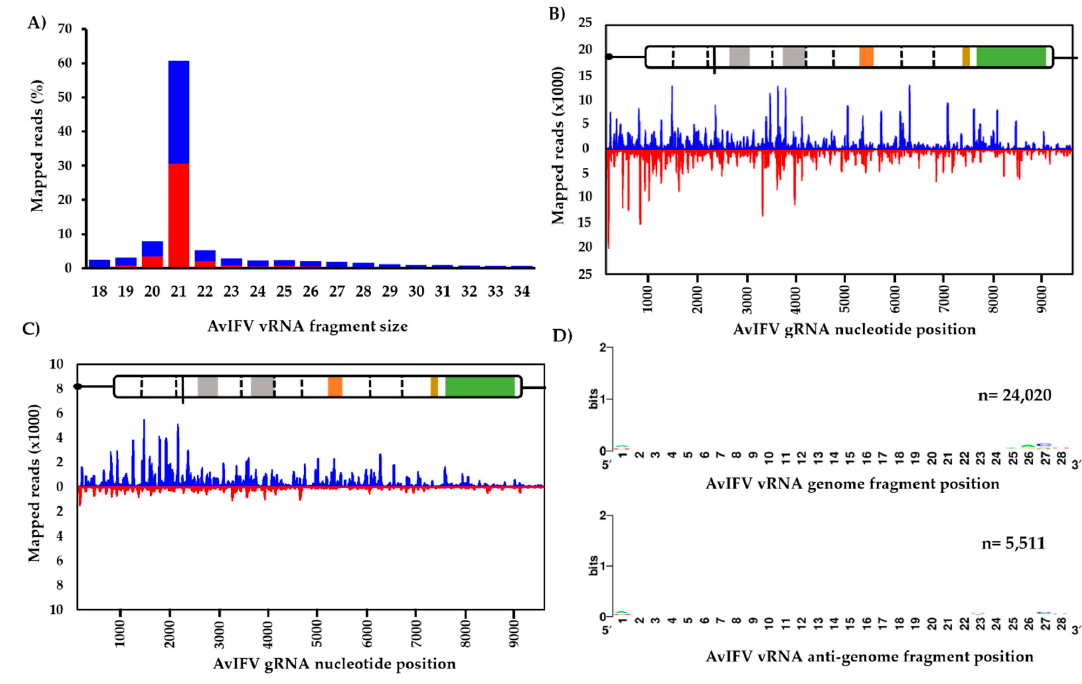
Figure 3. Virus-derived small RNAs derived from AvIFV replication in adult Ae. vexans arabiensis mosquitoes. ( A ) Profile of nucleotide lengths of virus-derived small RNAs mapped to the AvlFV genome. ( B ) Profile of 21 nt virus-derived short interfering RNAs and ( C ) virus-derived piRNA reads (24–29 nt) mapped to the AvIFV genome (blue) and anti-genome (red). ( D ) AvIFV does not produce vpiRNAs with the characteristic piRNA signature (adenine at position 10, A 10 , for sense RNA; upper panel and Uridine at position 1, U 1 for antisense RNA; lower panel).